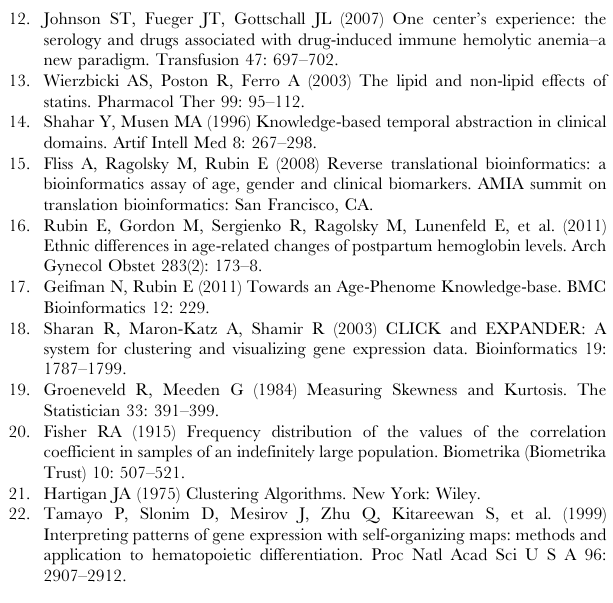
Table S1 Descriptive statistics. ( A ) Details of the biomarkers used in this study. Several statistical properties of each biomarker are provided, including the number of observations (N), minimal (min) maximal (max) and mean (mean) values, as well as the standard deviation (Std Dev). L Biomarker is natural-log trans- formed in the appropriate pre-processing/clustering pipeline; A Biomarker is linearly adjusted for age in the appropriate pre- processing/clustering. (B) The statistical properties of Health/life style variables used for enrichment analysis. For each variable, the code, a short description and the number of subjects that answered positively are recorded for both the training and the validation sets. Table S2 Details of the age adjustment process. For each variable, the correlation coefficient and the parameters used for age adjustment parameters are provided. Age adjustment is performed using the equation V 9 = V 2 ( a *age + b ) + m where V 9 is the adjusted value, V is the raw value and a , b and m are the adjustment parameters.